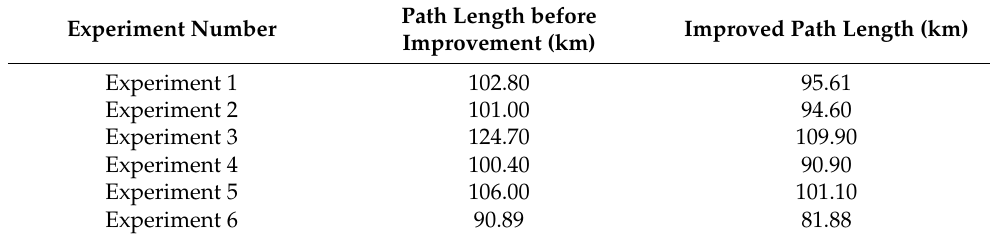
Table 2. Algorithm Simulation Data